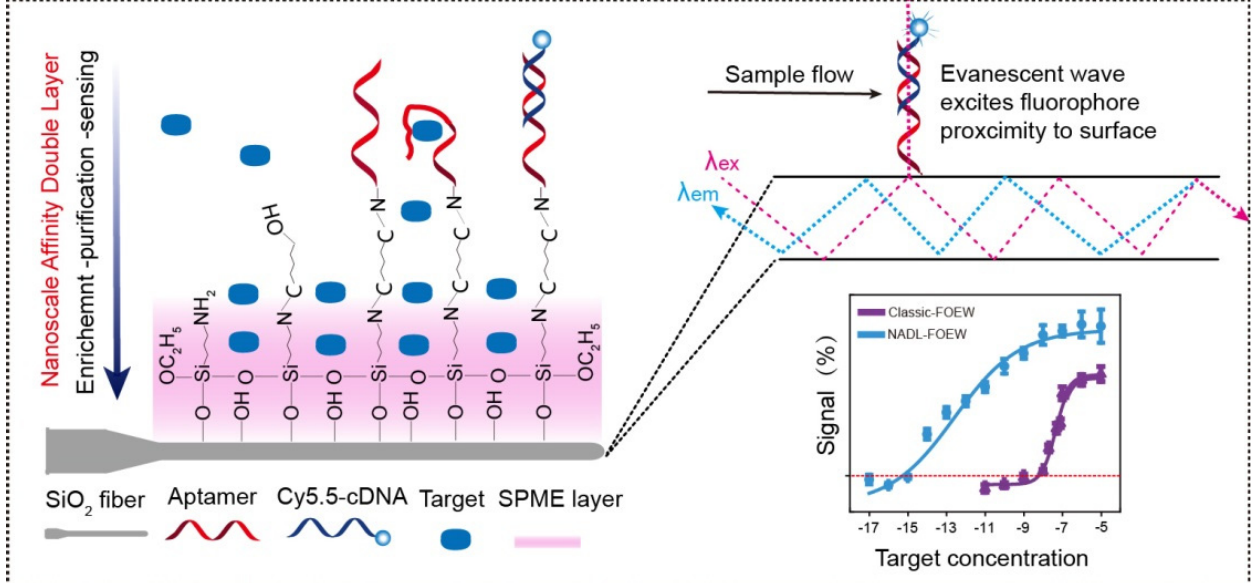
Figure 11. NADL-FOEW for rapid and ultrasensitive detection of small-molecule targets in environmental water, fresh milk, wine, and urine samples. Reprinted from Zhao et al. (2021) [50], Copyright (2021), with permission from American Chemical Society.